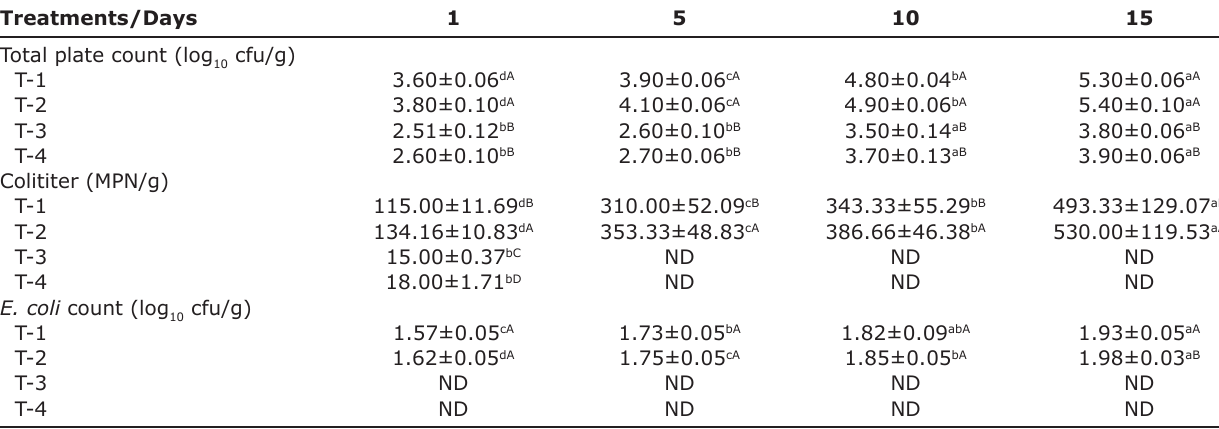
Table-3: Microbiological quality of Vawksa rep (smoked pork product) stored under vacuum packaging conditions at 4°C±1°C.